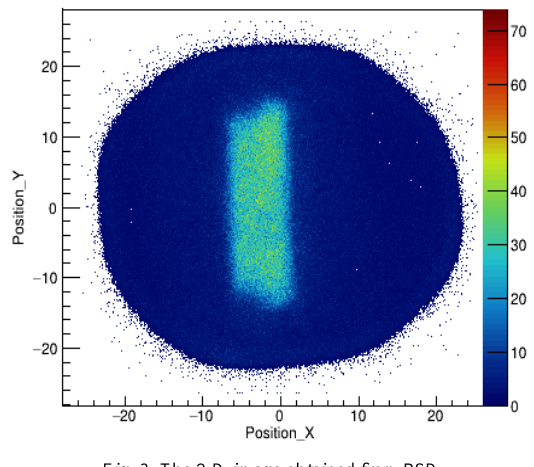
Fig. 3: The 2-D image obtained from PSD.